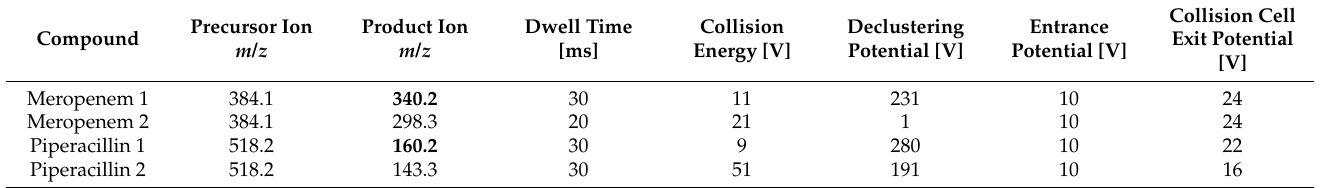
Table A2. Precursor ions m / z and product ions m / z of meropenem and piperacillin with correspond- ing applied mass spectrometric parameters of the developed LC-MS/MS method.